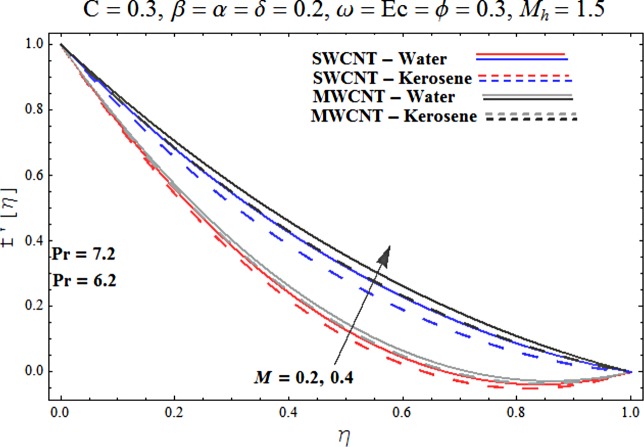
Effect of M on f′.